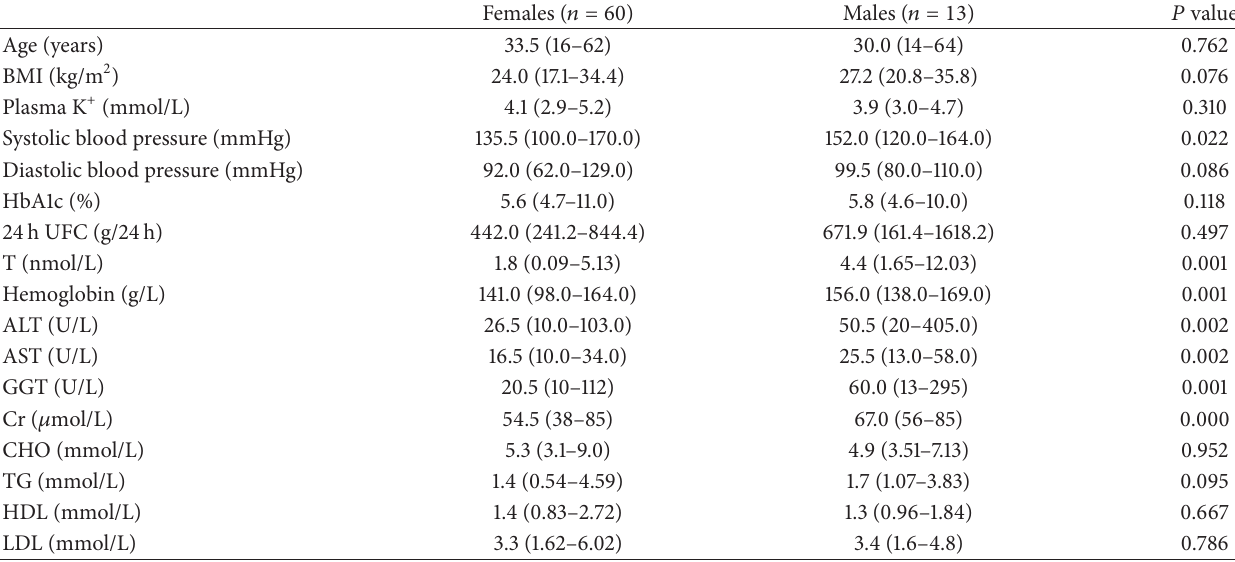
Table 1: Clinical features of CD by